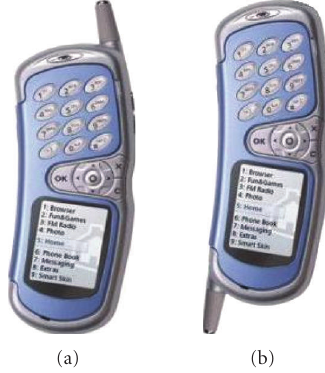
Figure 1: The physical model of (a) the handset released by Linux, and (b) the proposed handset with bottom-mounted antenna.